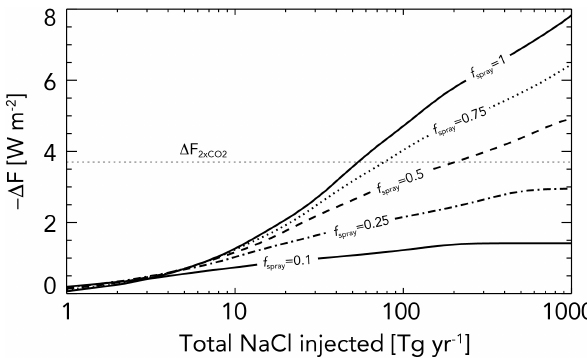
Figure 12. Sensitivity of the radiative forcing to different frac- tions f spray of the eligible ocean where sprayers operate. Forcing is shown as a function of the total (global) rate of salt mass injec- tion. The mass injected per sprayer is the same as that for scenario 2 (Sect. 4.1 and Fig. 5), and the sprayer density is the same in each case, i.e., the number of sprayers is proportional to f spray and is 100000 for f spray = 1. The geometric mean spray diameters are D s = 100nm, and the background is N 0 , acc = 100cm − 3 . All other parameters are the same as those used in Fig.